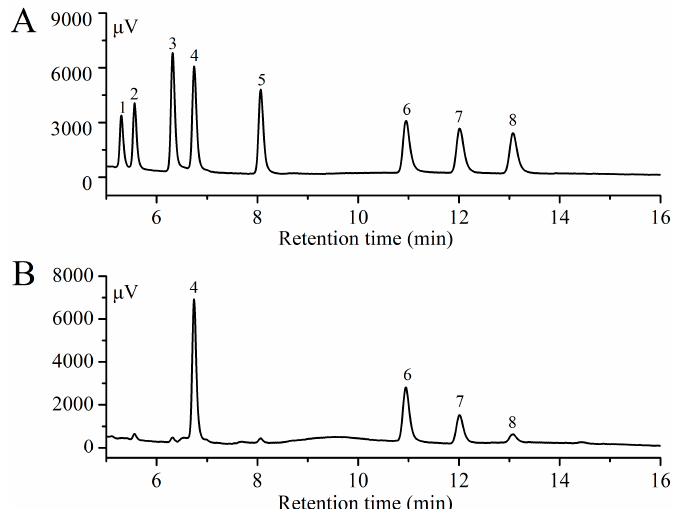
Figure 7. Gas chromatography (GC) chromatograms of monosaccharide. ( A ) Standard sugars; ( B ) En-OPS. Peaks: (1) rhamnose, (2) fucose, (3) ribose, (4) arabinose, (5) xylose, (6) mannose, (7) galactose, and (8) glucose.